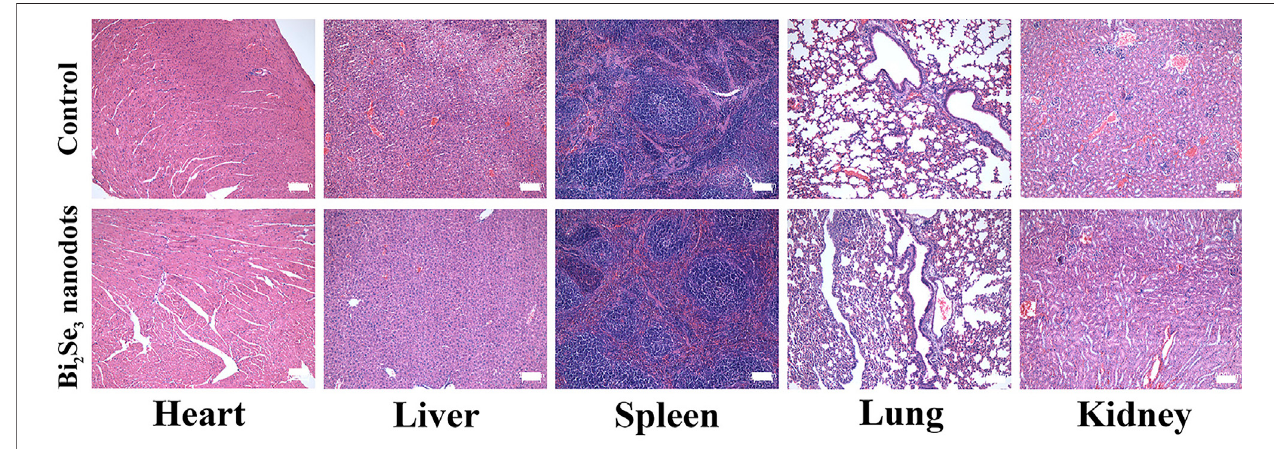
FIGURE 6 | H&E staining of major organs (heart, liver, spleen, lungs, and kidneys) of mice 30 days after injection of PEI-Bi 2 Se 3 nanodots. All scale bars (cid:1) 100 µm.